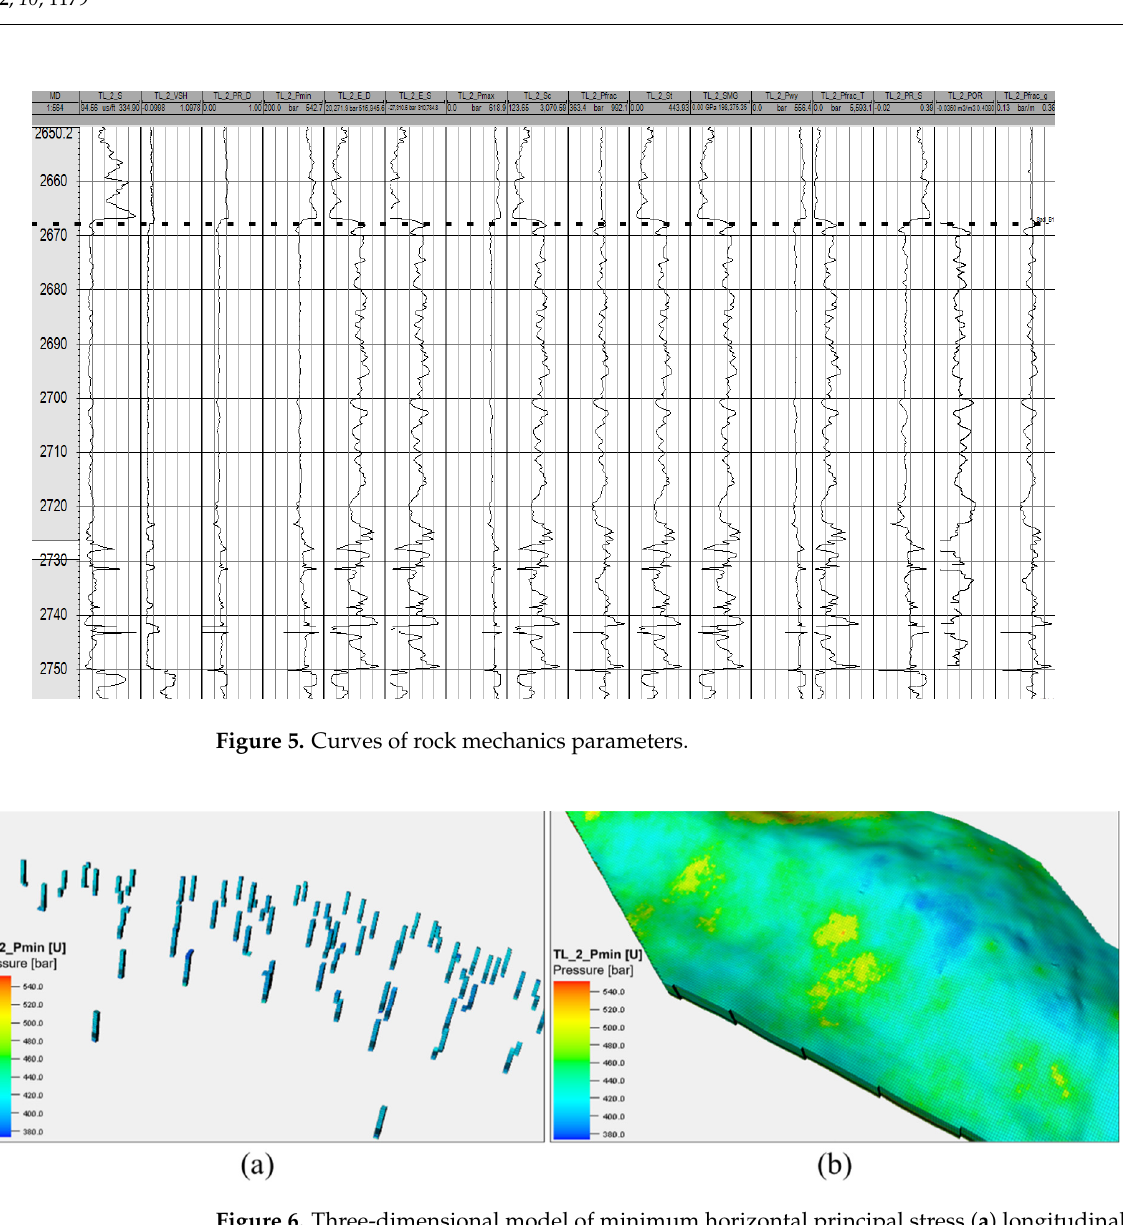
Figure 6. Three-dimensional model of minimum horizontal principal stress ( a ) longitudinal dispersion; ( b ) plane prediction.